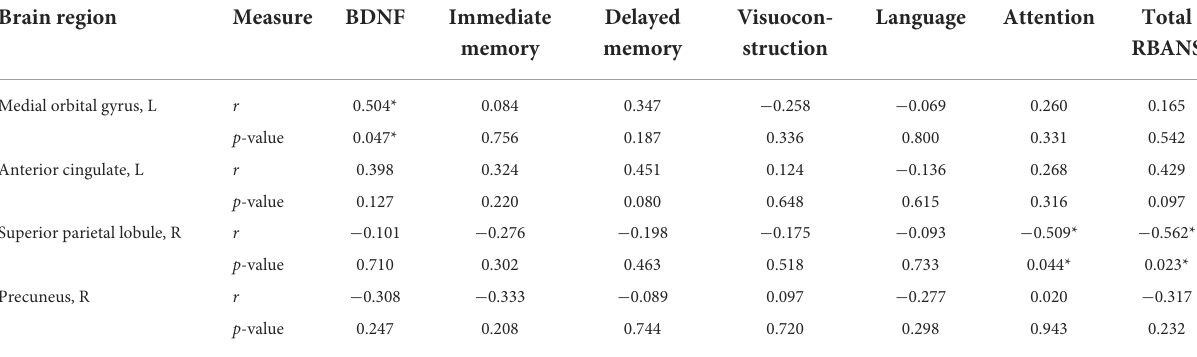
Delayed Visuocon- Language Attention Total memory memory struction RBANS